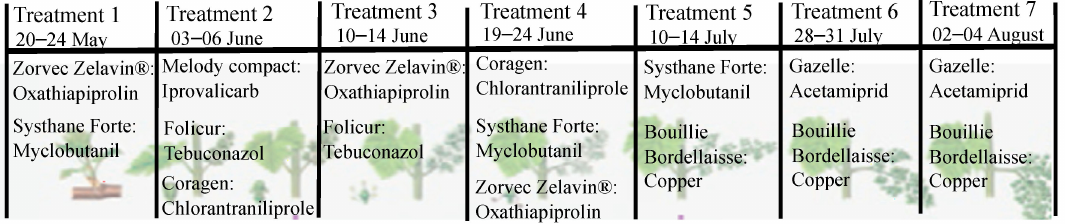
Figure 1. The phytosanitary treatments used at the vineyard (original